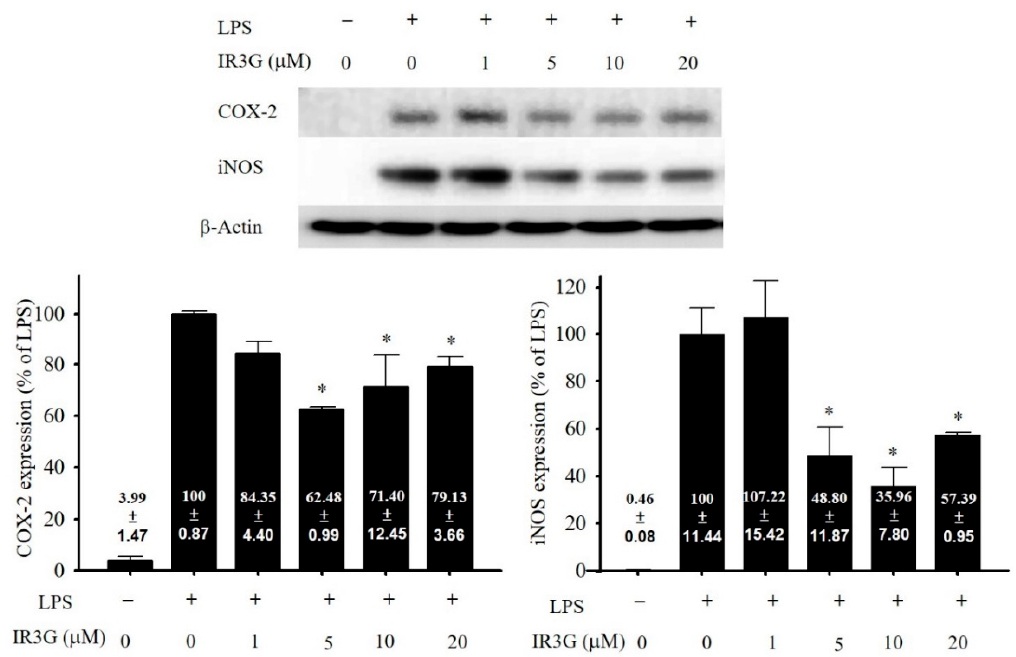
Figure 2. Anti ‐ inflammatory activity of Diplotaxis harra extract (DHE) through inhibiting the expres ‐ sion of proinflammatory proteins COX ‐ 2 ( A ) and iNOS ( B ). Dexamethasone (DEX) was used as the positive. The values are mean ± S.E.M. ( n = 6). *, Significantly different from LPS ‐ activated group ( p < 0.05).